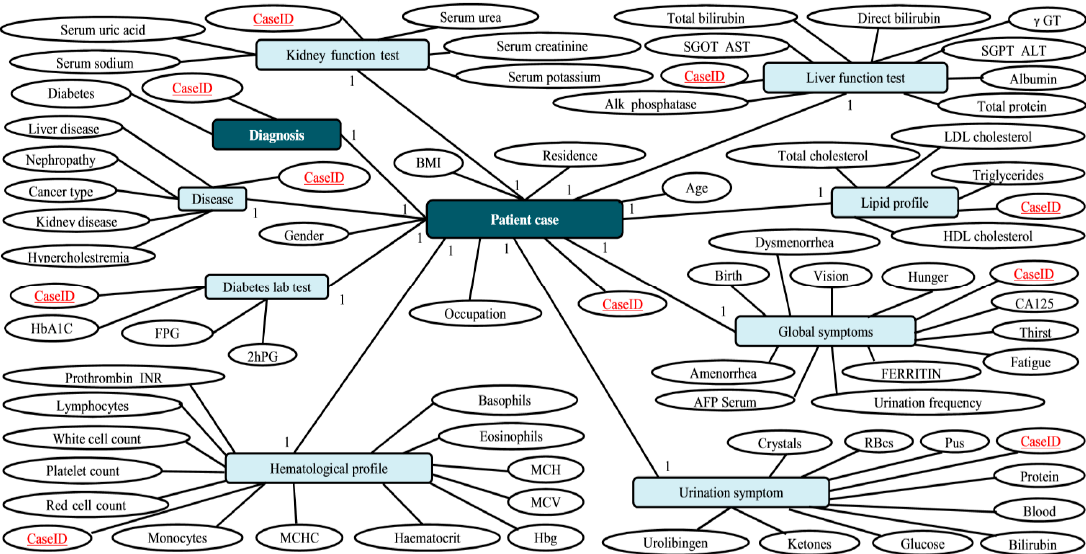
Figure 4. The crisp ontology model used in [38].